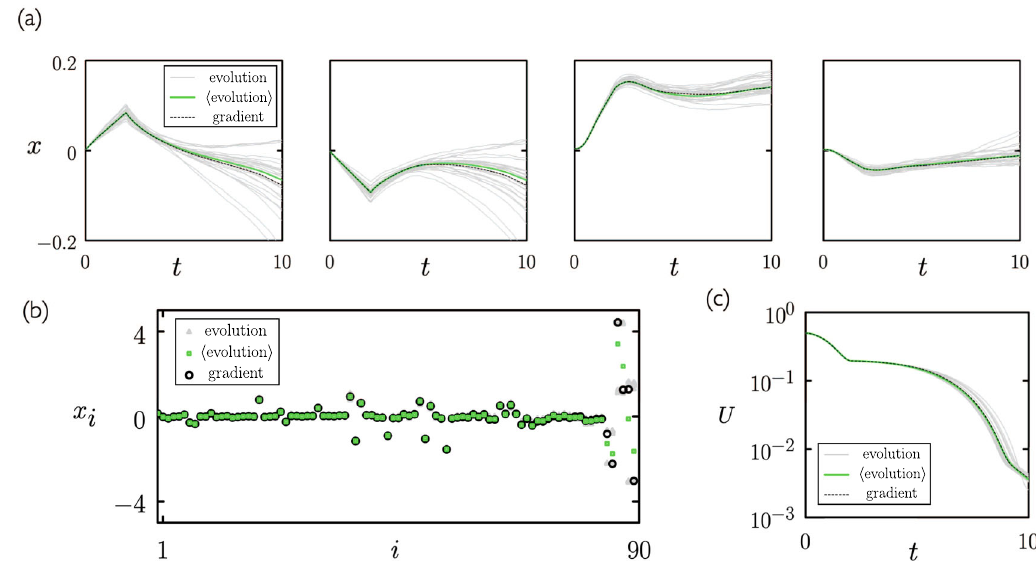
Fig. 1 Numerical illustration of the equivalence of gradient descent and neuroevolution in the case β = ∞ . a Evolution with time of 4 of the 90 weights of the neural network (11) under the gradient descent equation Eq. (12) (black: “ gradient ” stands for “ gradient descent ” ), and under neuroevolution with mutation scale λ = 1/10 [see (14)]. Here and in subsequent panels we show 25 independent neuroevolution trajectories (gray, marked “ evolution ” ) and the average of 1000 independent trajectories (green, marked “ evolution h